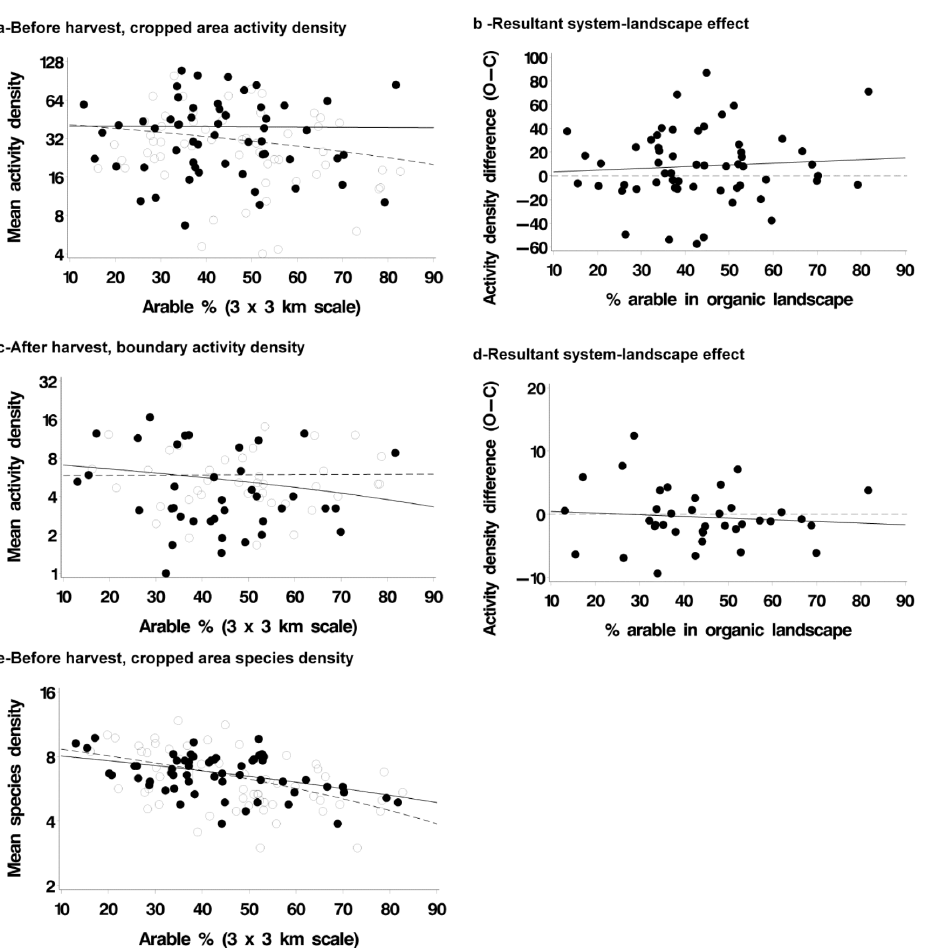
Fig 3. Effect of farming system and landscape on activity density of carabid beetles. Organic: solid lines, filled points; conventional: dotted line, open points. Plots in left hand panel: lines in plots are linear regressions plotted on log scale by system, points are farms. Plots in right hand panel: lines in plots are linear regression (solid line) and reference line (dotted at system difference = zero), points are farm pairs. Right hand panel extracts system effect from left hand panel.